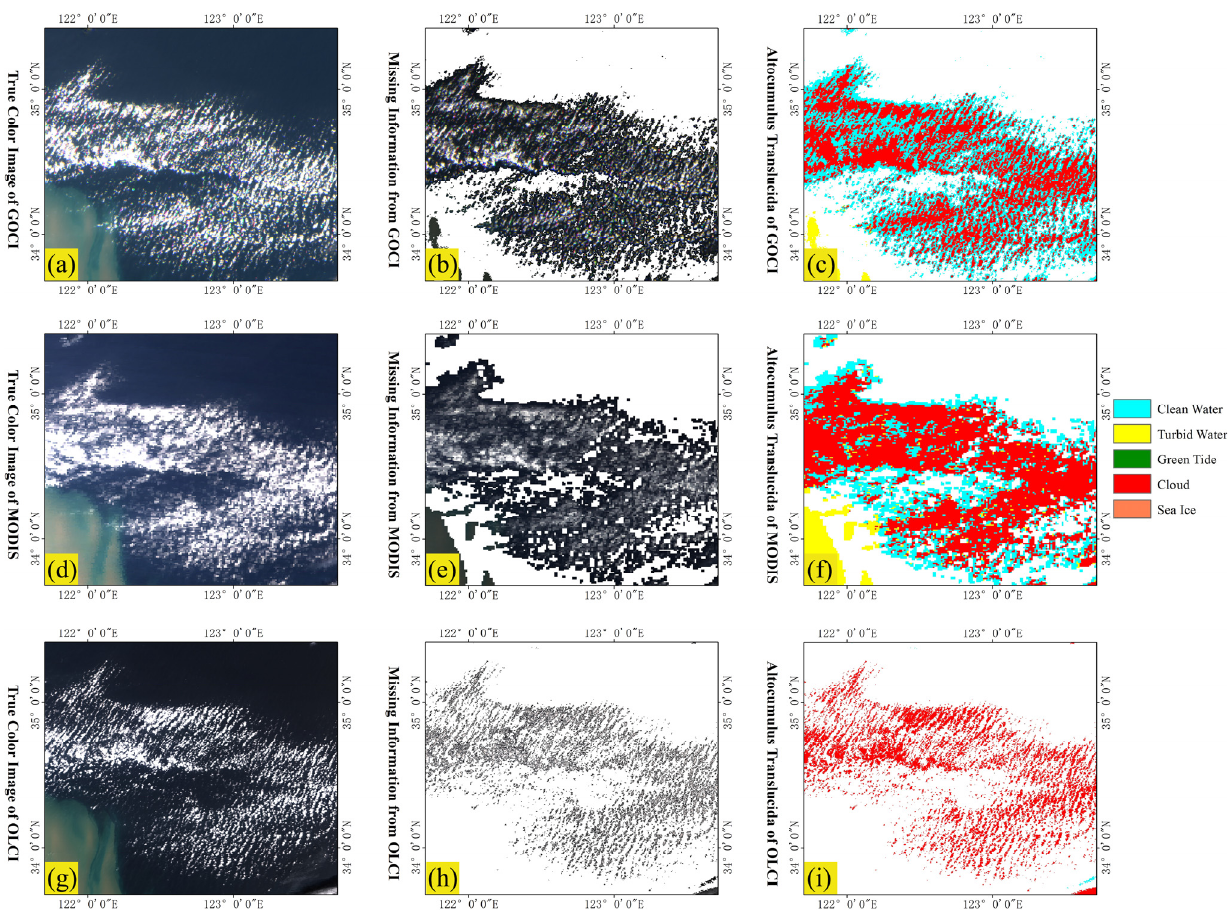
Figure 14. Schematic diagram of the missing position of altocumulus translucidus: ( a , d , g ) the true color images at the spatial locations of the altocumulus translucidus for GOCI, MODIS and OLCI data, respectively; ( b , e , h ) the condition of the data-free area; ( c , f , i ) the identification status of the marine objects in the data-free area.